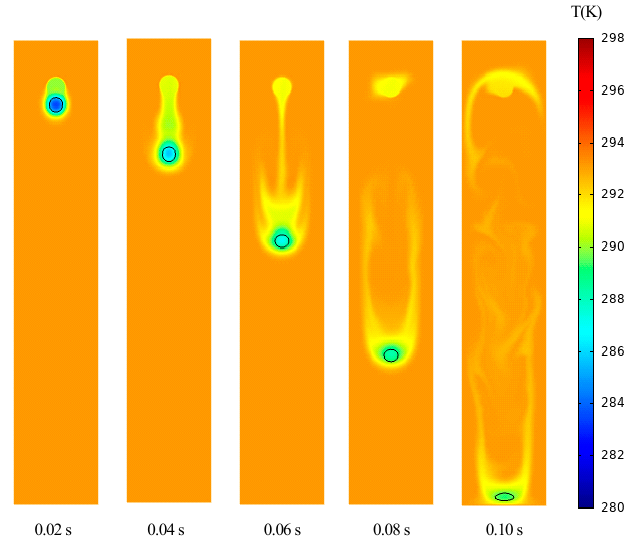
Figure 10. Temperature distribution of a free-falling water droplet in air at 293.15 K. The temperature of water droplets and the surrounding air changes most acutely in the air at 263.15 K. at 0.06 s, and the temperature of water droplets drops to about 275 K. There is a cup-shaped high-temperature region at the tail of water droplets at about 280 K. At 0.1 s, the temperature of water droplets drops to about 273 K, and there is a necklace- shaped high-temperature region at the tail of water droplets. When the air temperature is as low as 253.15 K and 243.15 K, the droplet temperature decreases rapidly, and the change in ambient air temperature weakens. At 0.06 s, the internal temperature of the droplet drops to 275 K and 268 K, respectively, while at 0.1 s, the internal temperature of the drop- let drops to 270 K and 260 K, respectively. The high-temperature region of the water drop- let tail becomes weak and shallow.